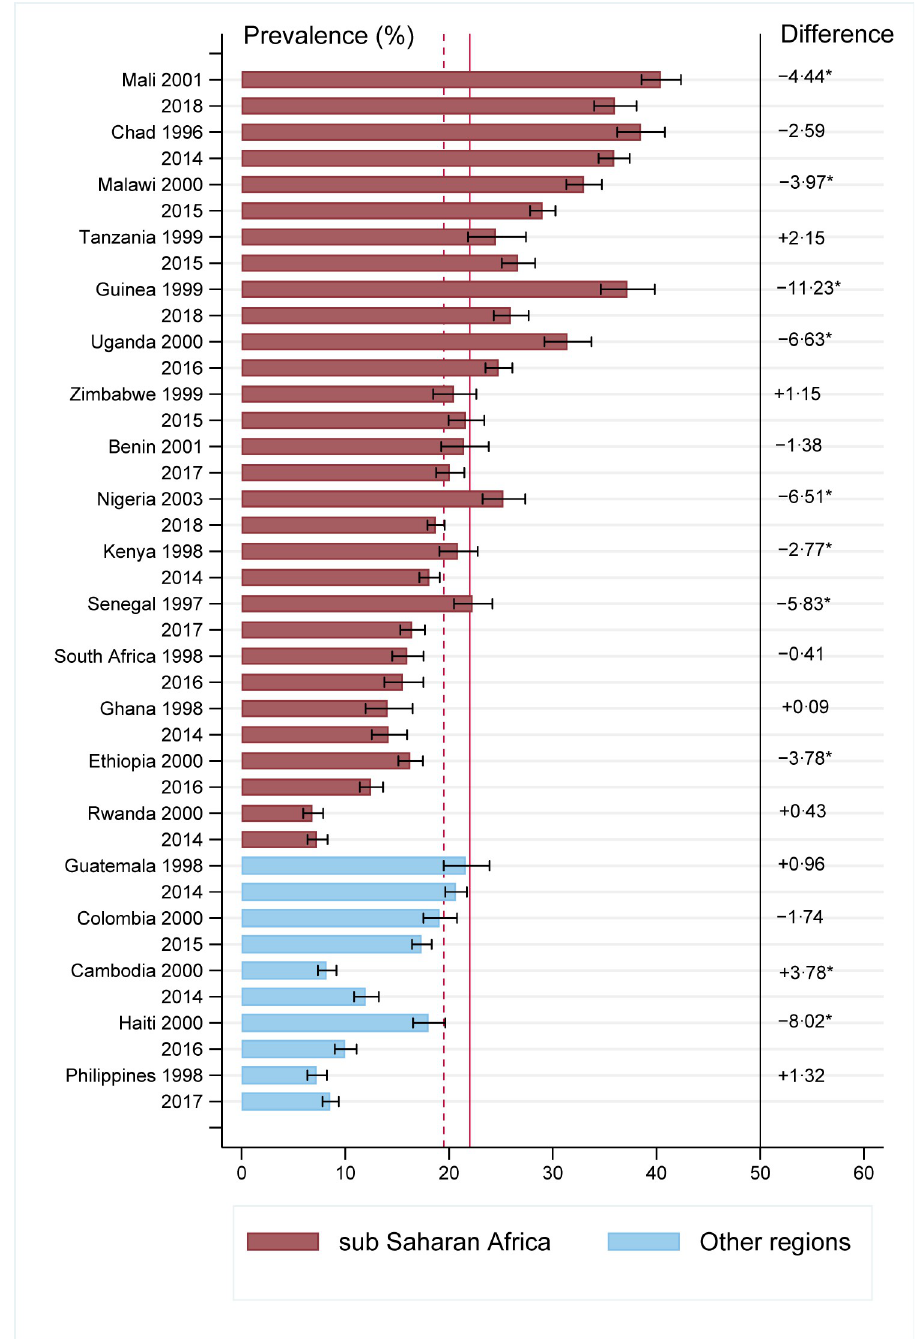
Fig 1. Transition in the national level prevalence of adolescent motherhood in LMICs, 1996–2018 (countries are ranked by endline survey prevalence). � Statistically significant. The solid and short-dash lines represent the global mean prevalence of adolescent motherhood in the study countries, at baseline and endline, respectively. Negative and positive differences represent reduction and increment in the prevalence of adolescent motherhood, respectively.